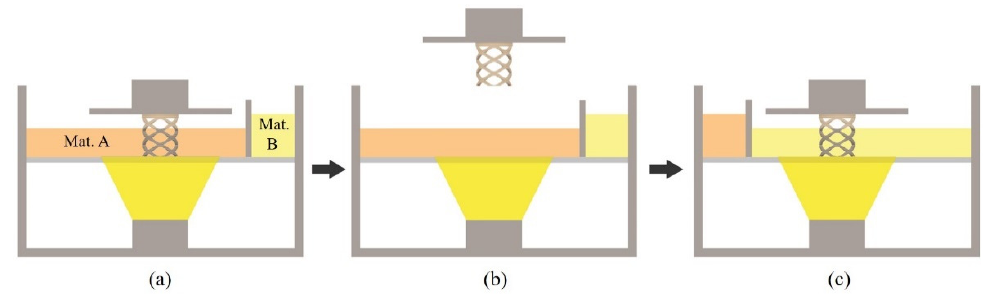
Figure 9. Schematic diagram of the suggested process: ( a ) photo-polymerization of material A; ( b ) moving the separator for material switching; ( c ) photo-polymerization of material